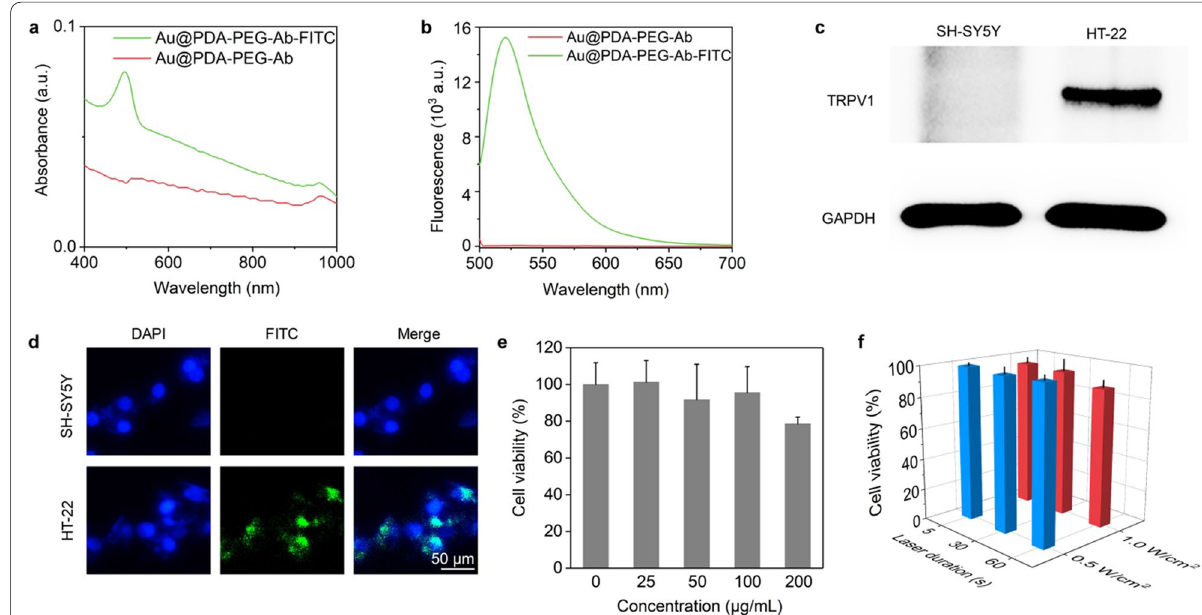
Fig. 4 Cellular uptake and cytotoxicity of Au nanoparticles. a UV–vis spectra of FITC modified and unmodified Au nanoparticles. b Fluorescence spectra of FITC modified and unmodified Au nanoparticles. c Western blotting for TRPV1 from SH-SY5Y and HT-22 cells. d Cellular uptake of FITC modified Au nanoparticles. e Cell viability of HT-22 treated with different concentrations of Au@PDA-PEG-Ab for 24 h. f Cell viability of HT-22 treated with NIR-II laser irradiation of different power intensities and laser